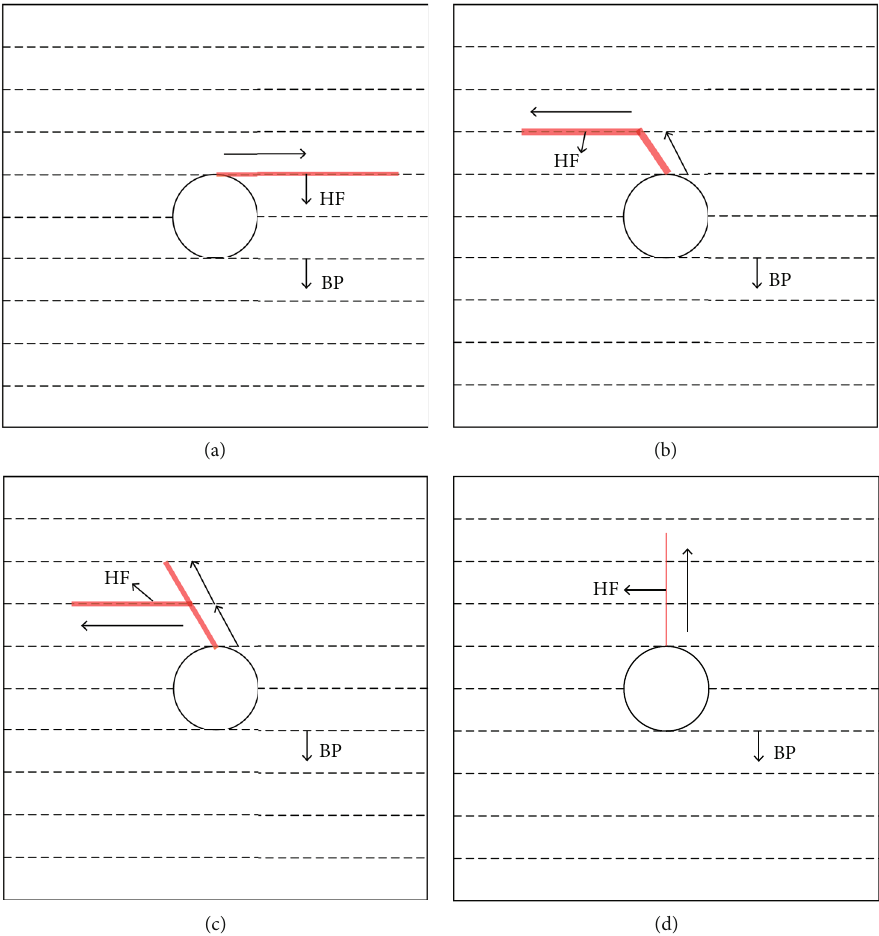
Figure 10: Four intersection scenarios between hydraulic fractures (HF) and bedding planes (BP): (a) inserting, (b) L-shape crossing, (c) T- shape crossing, and (d) direct